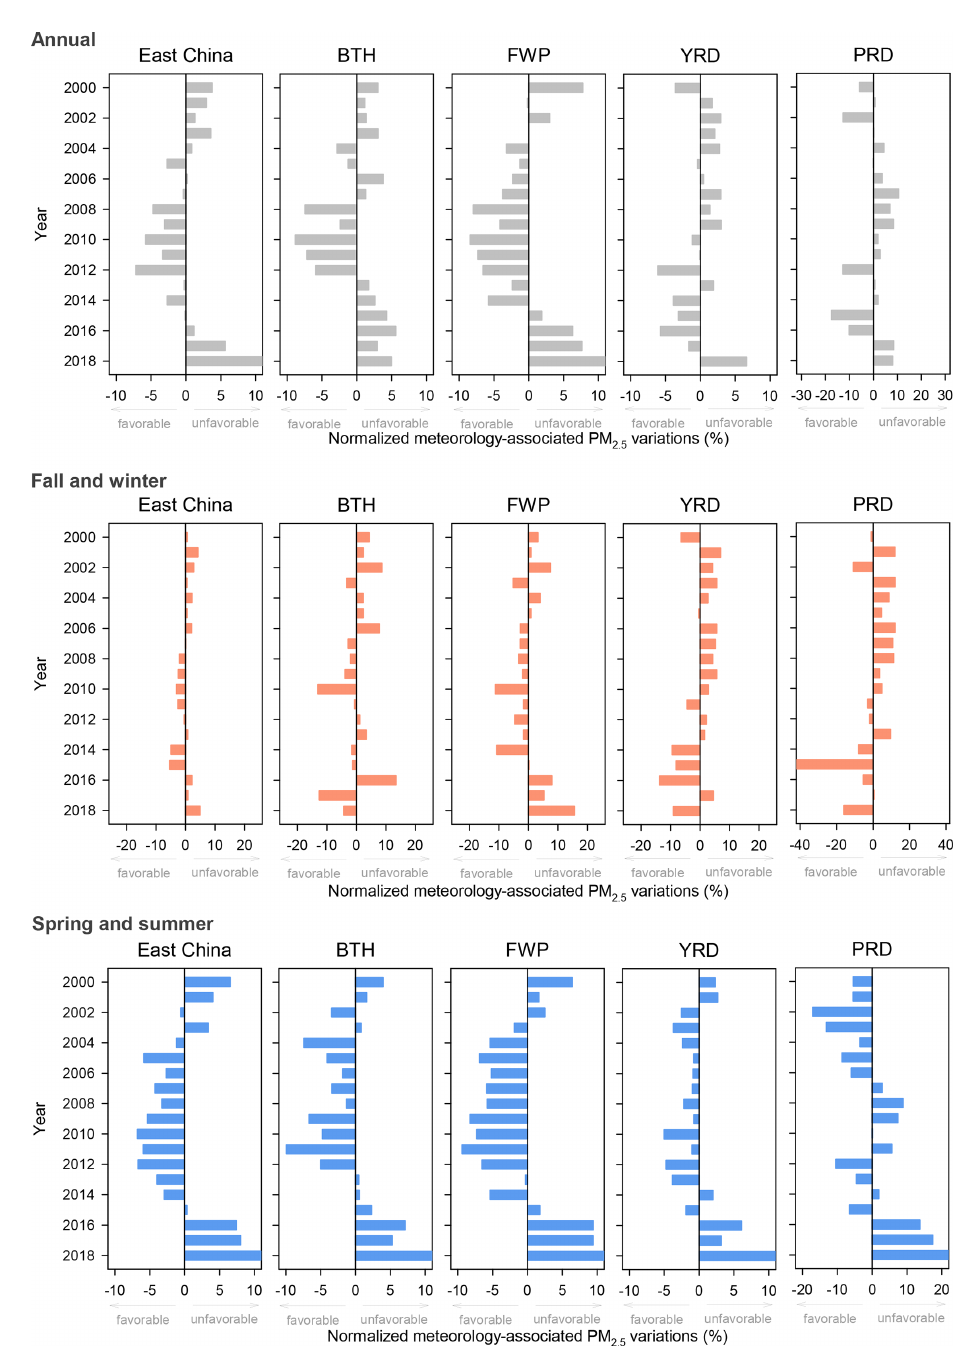
Figure A3. The CMAQ estimated relative impact of meteorology on annual average PM 2 . 5 (top row), relative impact of meteorology on average PM 2 . 5 in fall–winter (September, October, November, December, January in next year, and February in next year) (middle), and relative impact of meteorology on average PM 2 . 5 in spring–summer (bottom row) with the long-term trends estimated by polynomial and linear regressions over eastern China, BTH, FWP, YRD, and